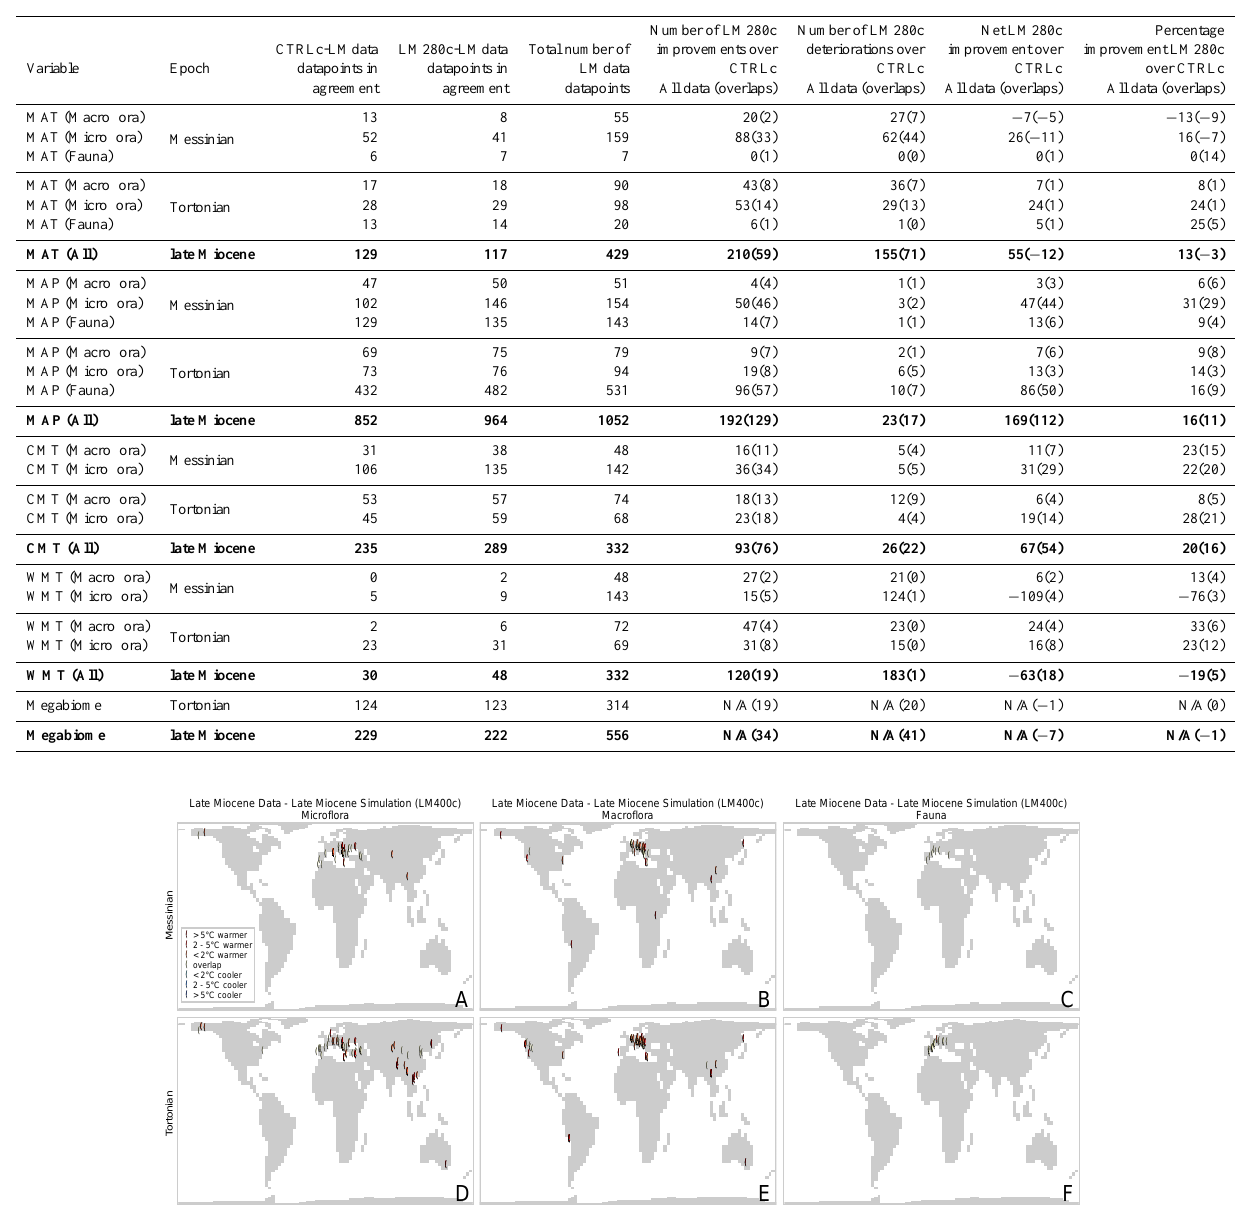
Table 2. Results from the model–data comparison for modern and late Miocene palaeogeography.